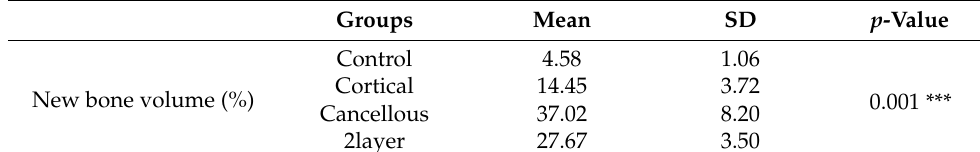
Table 2. Mean and standard deviation (SD) of new bone volume ( n = 6).